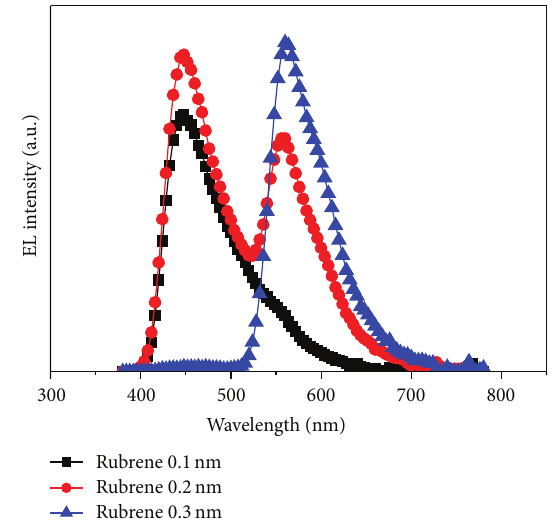
Figure 4: The electroluminescence spectra of the devices with var- ious thicknesses of Rubrene layer at